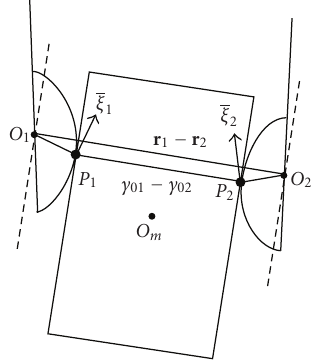
Figure 6: Minimization of the squared norm (cid:5) r 1 − r 2 (cid:5) 2 over rolling motions is attained when the straight line P 1 P 2 connecting the two contact points becomes parallel to the vector ( r 1 − r 2 ); that is, O 1 O 2 becomes parallel to P 1 P 2